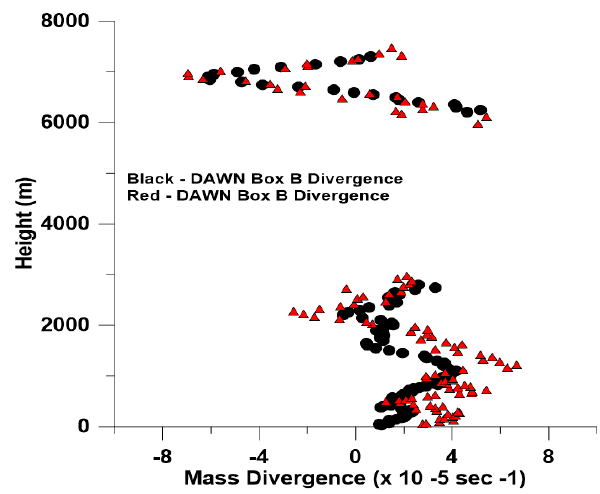
Figure 17. Mass divergence computed over Box A and Box B during 27 May 2017.